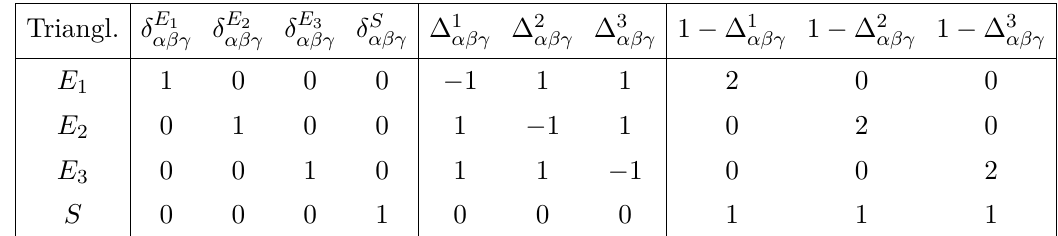
Table 1 . The values of the step functions δ T resp., for the different triangulations are